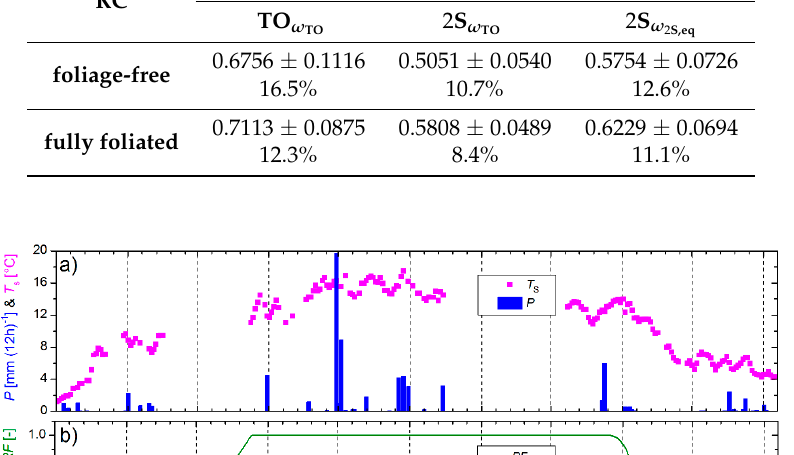
Table 2. Vegetation optical depths (cid:104) τ RC (cid:105) ± ∆ τ RC and relative variability σ τ RC = ∆ τ RC / (cid:104) τ RC (cid:105) retrieved with the “reference” RC = TO ω foliage-free and the fully foliated forest canopy.